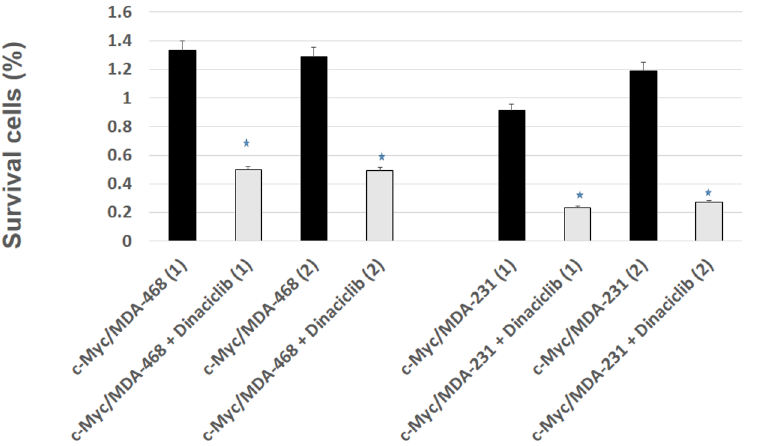
Fig 5. CDK inhibitor induced cell death in Myc overexpressing AA and EA cells. The cells were treated with Dinaciclib(10 nM), a CDK inhibitor for 72 h. Cell viabilitywas then analyzedby an MTT assay. Dinaciclib treatment significantly inhibitsof both Myc overexpressing cells. Bars, mean + S.E. of triplicate determinants ( * P < 0.05).